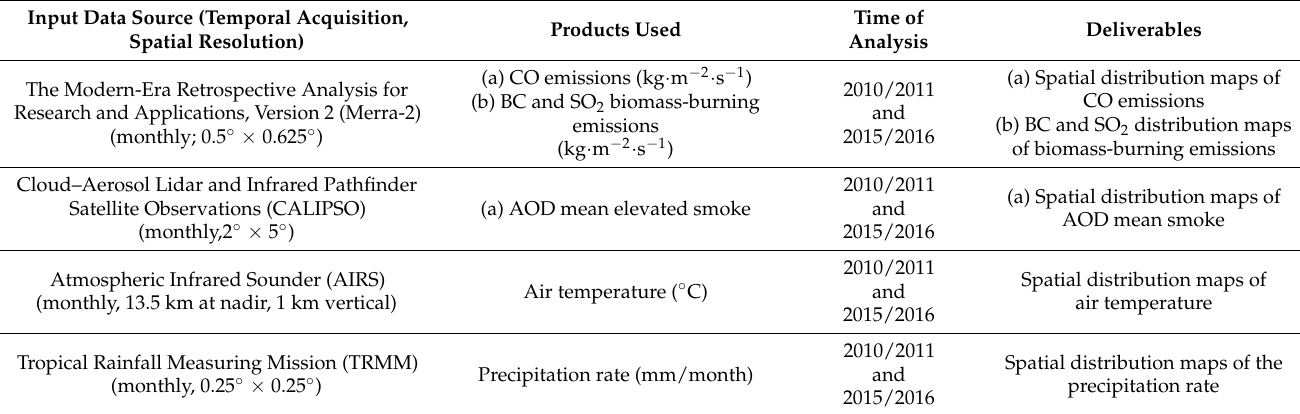
Table 1. Summary of the parameters used in this